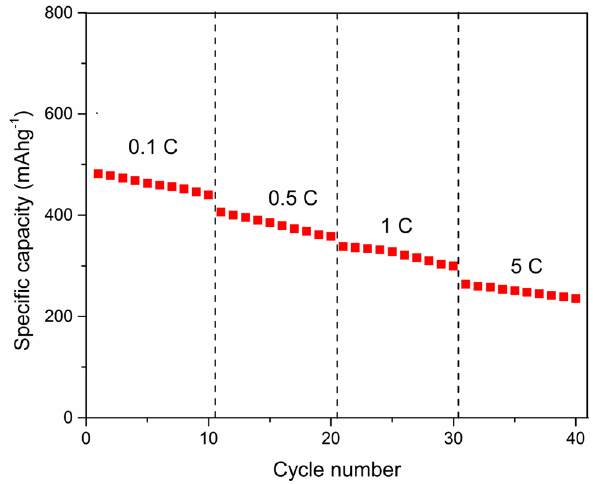
Fig. 4 Discharge cycle performance of SnO–V2O5–SiO2 glass